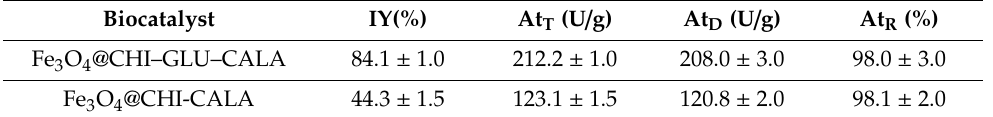
Table 1. Immobilization parameters of Fe 3 O 4 @CHI–GLU–CALA and Fe 3 O 4 @CHI-CALA: